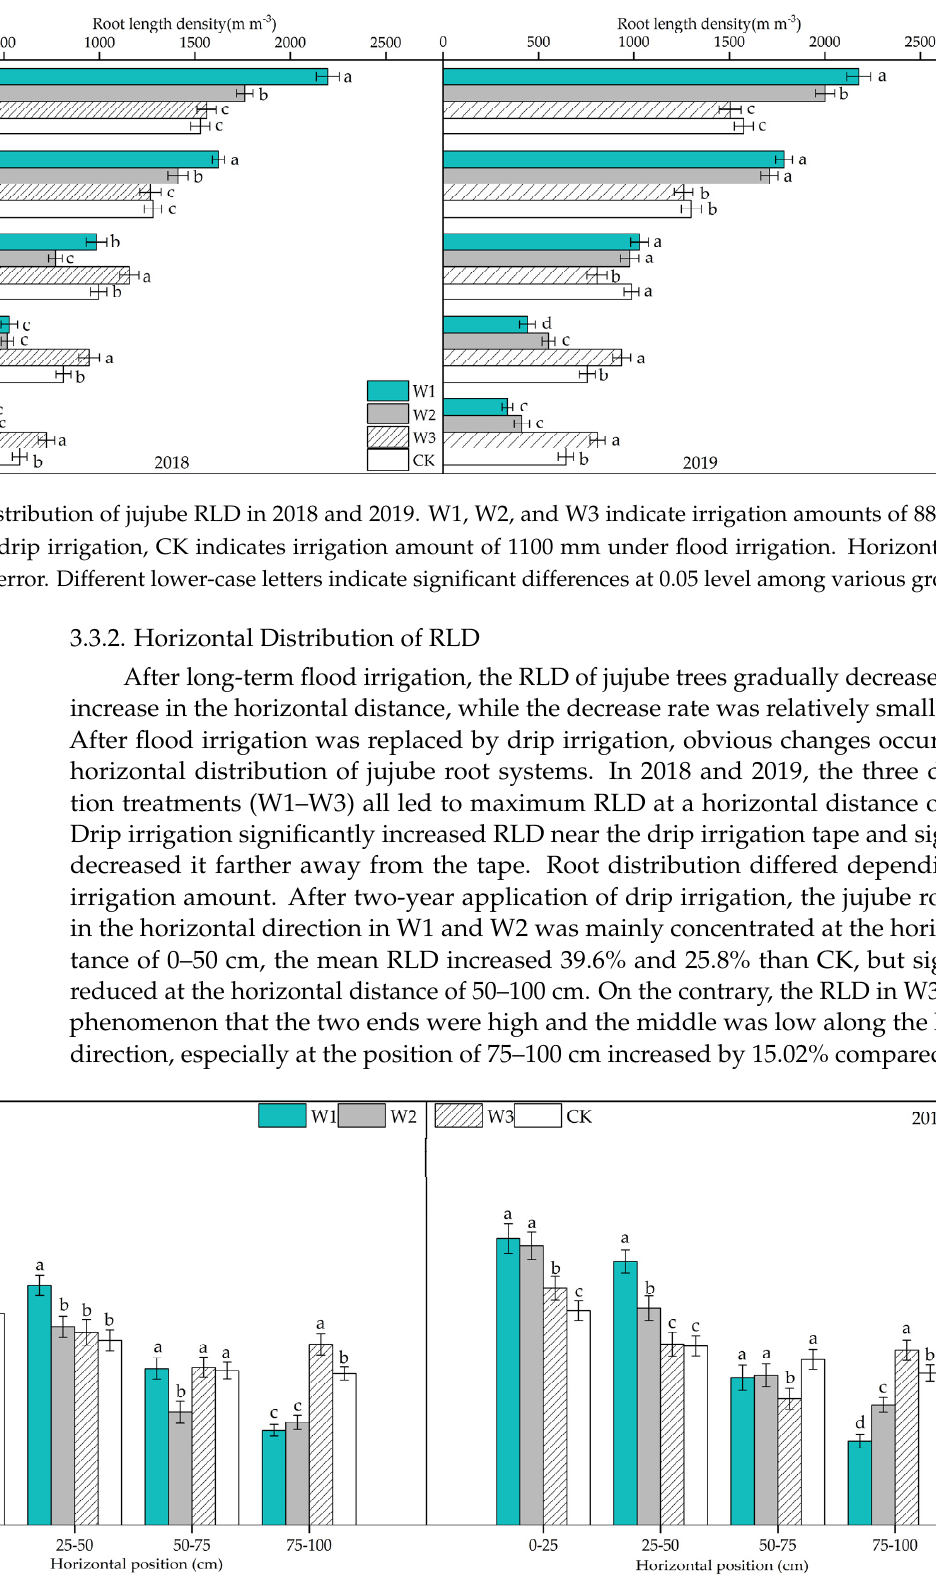
Figure 7. Horizontal distribution of jujube RLD in 2018 and 2019. W1, W2, and W3 indicate irrigation amounts of 880, 660, and 440 mm under drip irrigation, CK indicates irrigation amount of 1100 mm under flood irrigation. The horizontal bar represented standard error. Different lower-case letters indicate significant differences at 0.05 level among various groups.